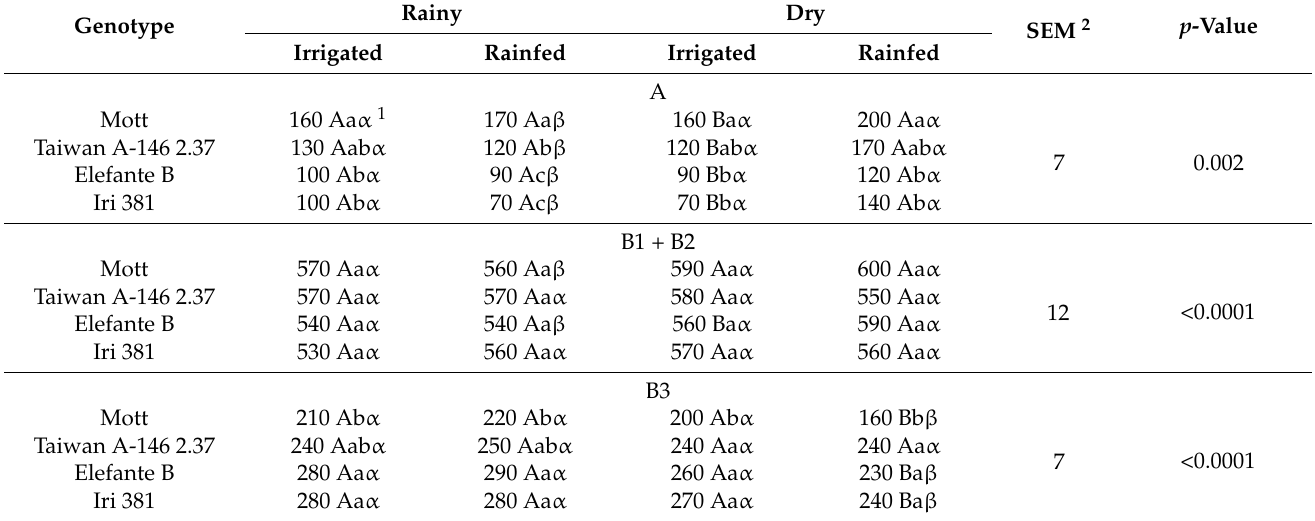
Table 9. Leaf protein fractionation (g/kg crude protein) as affected by the interaction between irrigation, genotype, and season for elephantgrass at Garanhuns, Pernambuco, Brazil. Genotype